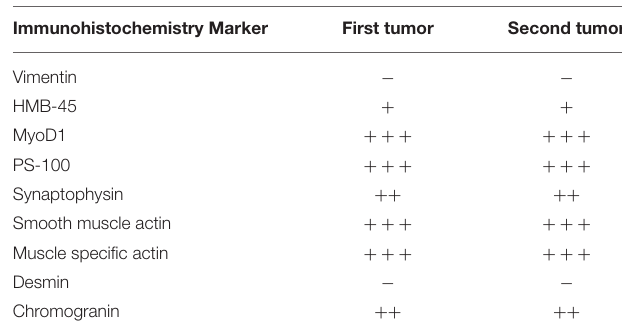
TABLE 1 | Immunohistochemistry